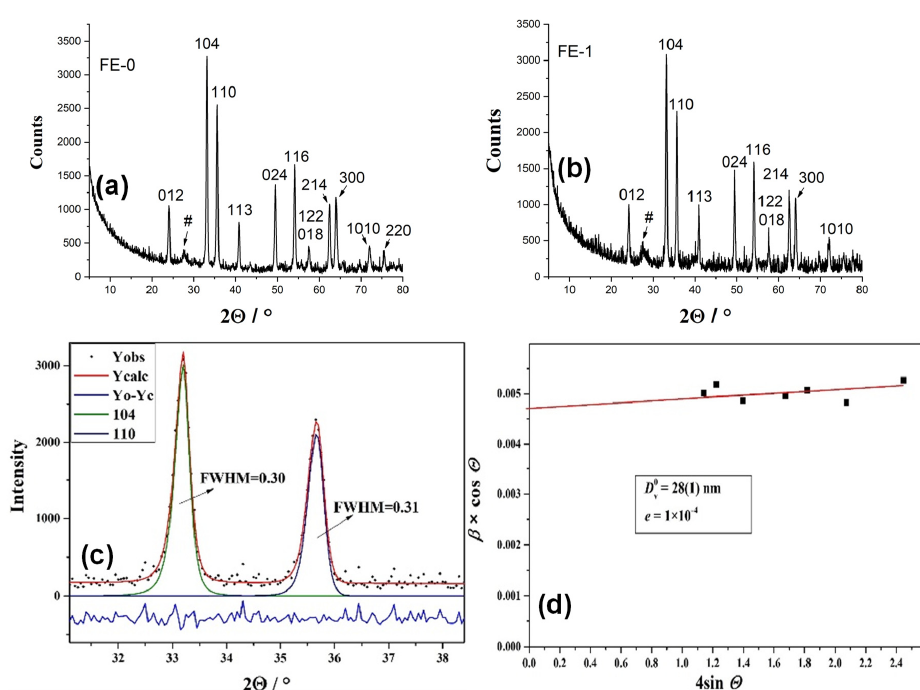
Figure 2. ( a ) XRD patterns of samples FE-0, # indicates unidentified maxima; ( b ) XRD patterns of samples FE-1. The both samples are assigned in accordance with the ICDD card 33-0664 (hematite). The hkl indices of hematite are indicated, # indicates unidentified maxima; ( c ) the results of individual profile fitting of the hematite diffraction lines 104 and 110 in the sample FE-1; ( d ) Williamson–Hall analysis of hematite in the sample FE-1. The value of the volume-averaged domain size ( D 0 v ) was obtained from the intercept on the y -axis, and the value of the upper limit of microstrains ( e ) from the slope of the line.